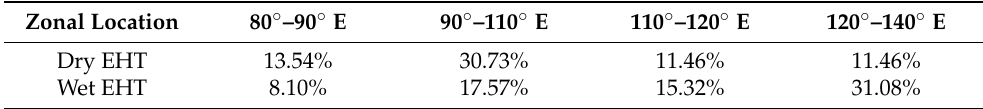
Table 2. Zonal locations distribution of continental high on dry and wet EHT days.